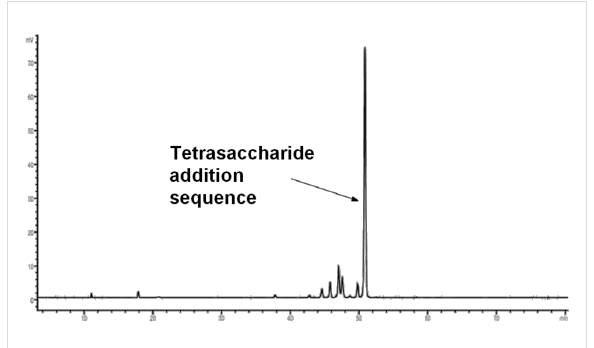
Figure 4: HPLC chromatogram of the crude products of the attempted AGA of SP3 trisaccharide 9 ; conditions: YMC Diol 300, H/EtOAc, 0% EtOAc (5 min) to 70% EtOAc (70 min),